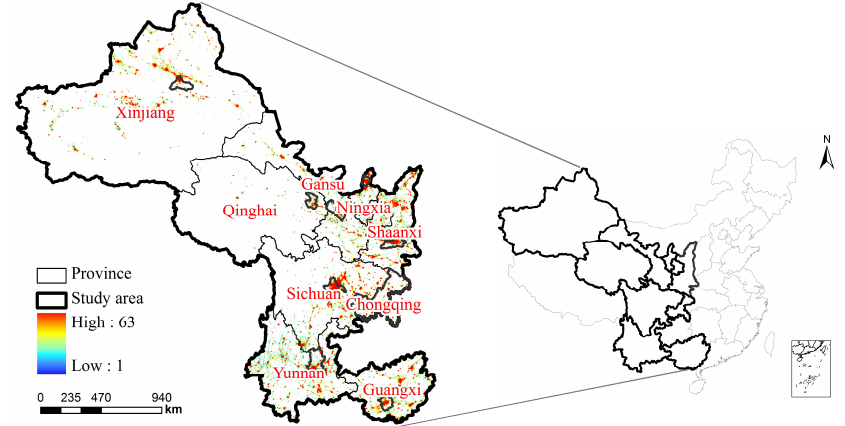
Figure 1. Nighttime light image covering nine Chinese provinces in the Silk Road Economic Belt in 2010.